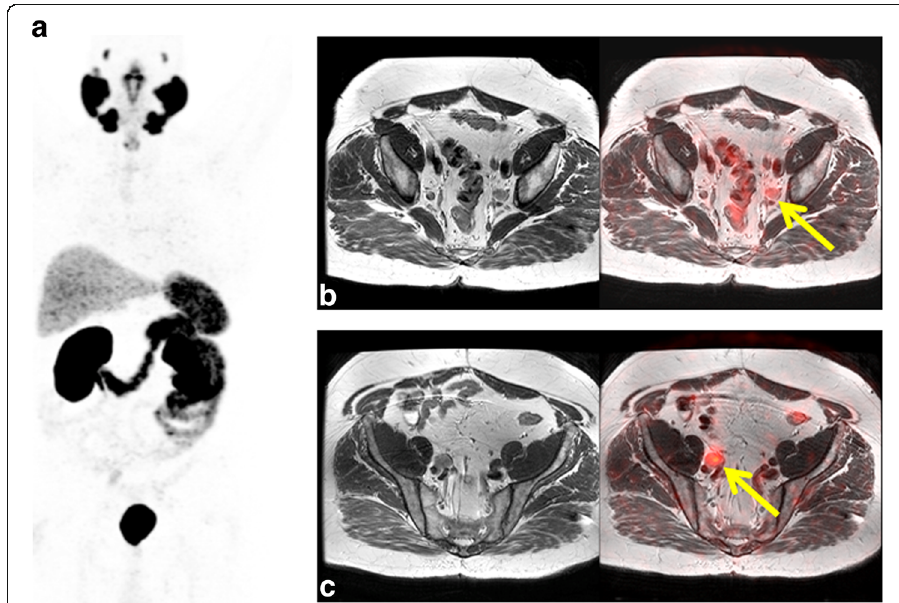
Fig. 3 Patient 8. A 58-year-old-patient with PSA relapse (PSA level 4.44 ng/ml) after radical prostatectomy. MIP ( a ), MR and 68 Ga-PSMA PET/MR ( b - c ) images showing pelvic lymph node metastasis (yellow